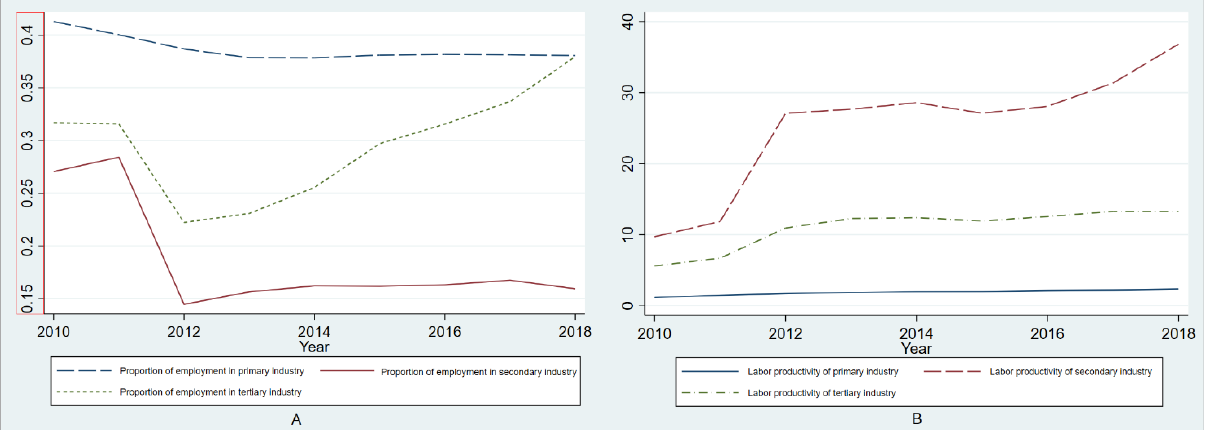
Figure 4. (A) Proportion of employed population in the tertiary industry in Shaanxi and (B) Labor productivity of three Figure 4. ( A ) Proportion of employed population in the tertiary industry in Shaanxi and ( B ) Labor industries in Shaanxi. productivity of three industries in